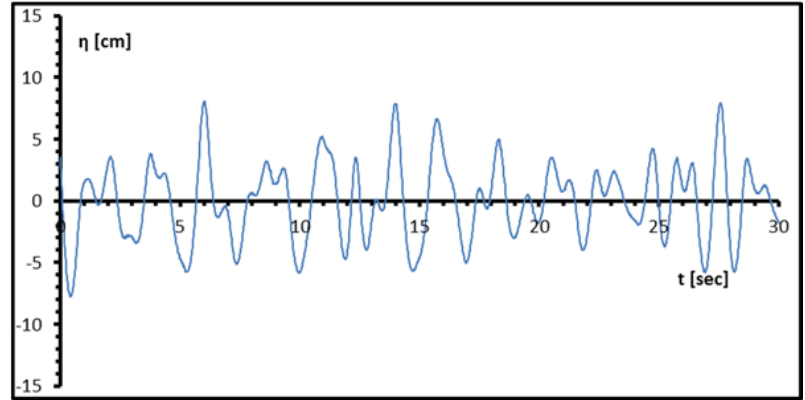
Figure 9. Water elevation η time series for Experiment #6.